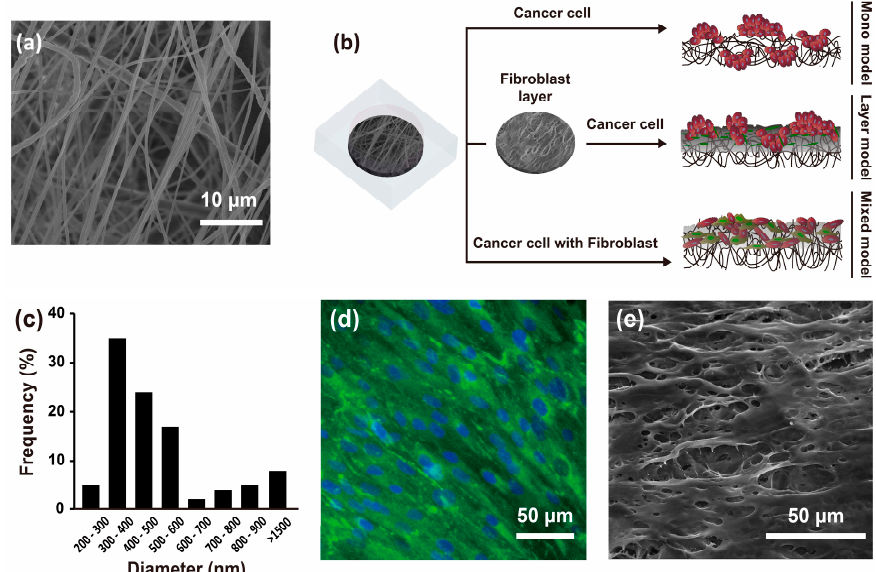
Figure 1. SEM image of the nanofibrous membrane ( a ) and schematic of the experimental design ( b ); Diameter distribution of the nanofibrous membrane ( c ) ( n = 10); Fibroblast layer on a nanofibrous membrane after three days of culture with staining of collagen type I (green) and the nucleus (blue) ( d ); SEM image of the fibroblast layer on the nanofibrous membrane ( e ).